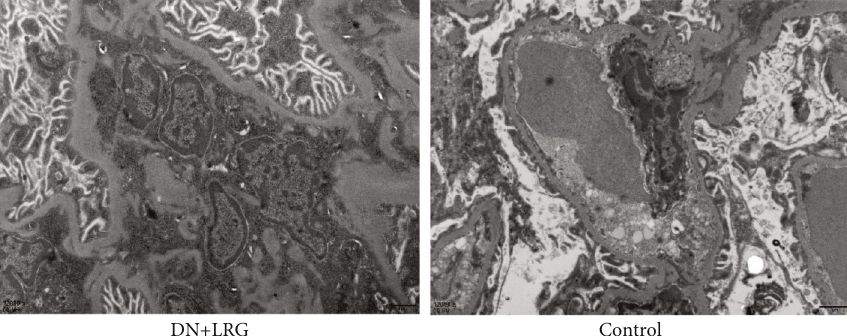
Figure 10: Changes of the renal structure detected by electron microscopy. Control: diabetic nephropathy group; DN+LRG: diabetic nephropathy+liraglutide group.